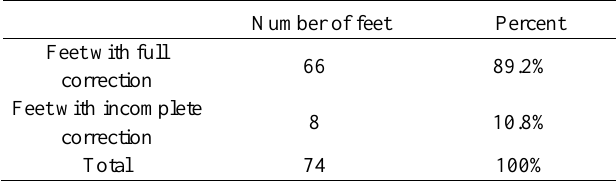
Table 4 : (feet with full and incomplete